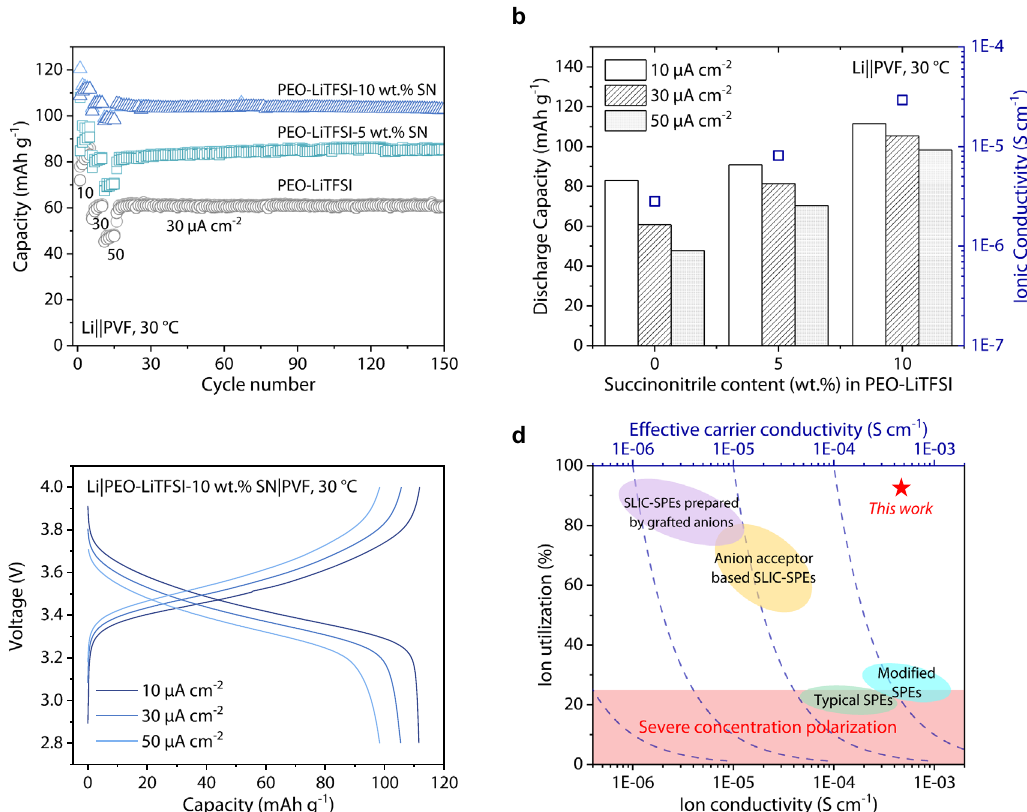
Fig. 6 Li||PVF cells testing using succinonitrile as solid electrolyte additive. a The cycle performance of SPEs with/without SN content. b Correlation between ionic conductivity of SPE and capacity of Li||PVF cell at 30 °C. c The potential pro fi les of Li|PEO-LiTFSI-10 wt.% SN|PVF cell at 30 °C. d Comparison of the effective carrier number of this work and other types of SPEs, where the ionic conductivity was collected at operating